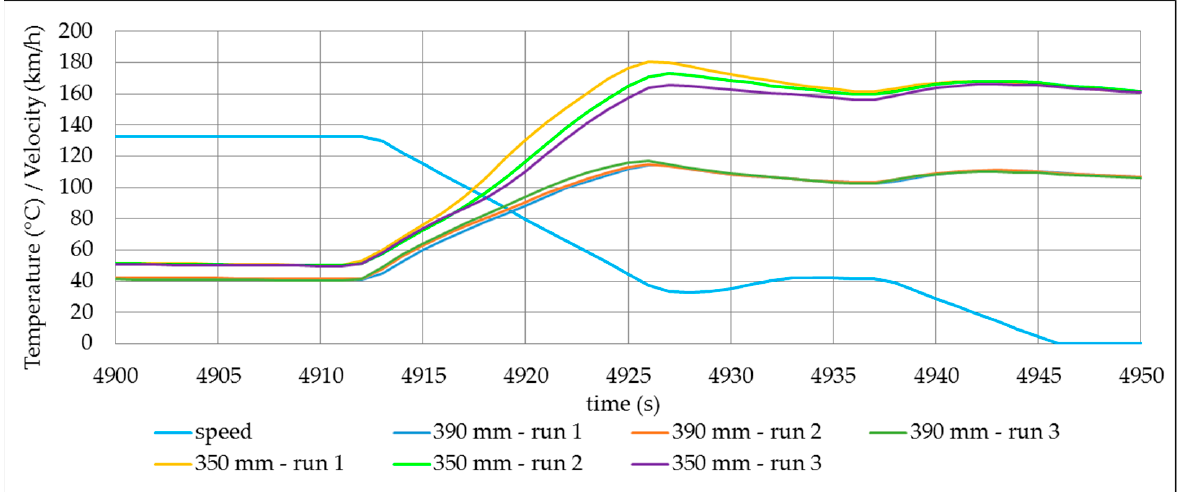
Figure 14. Temperature profile of the conventional grey cast iron (GCI) discs along brake event 106 of trip #10 of the WLTP brake cycle (Vehicles 1 and 2).